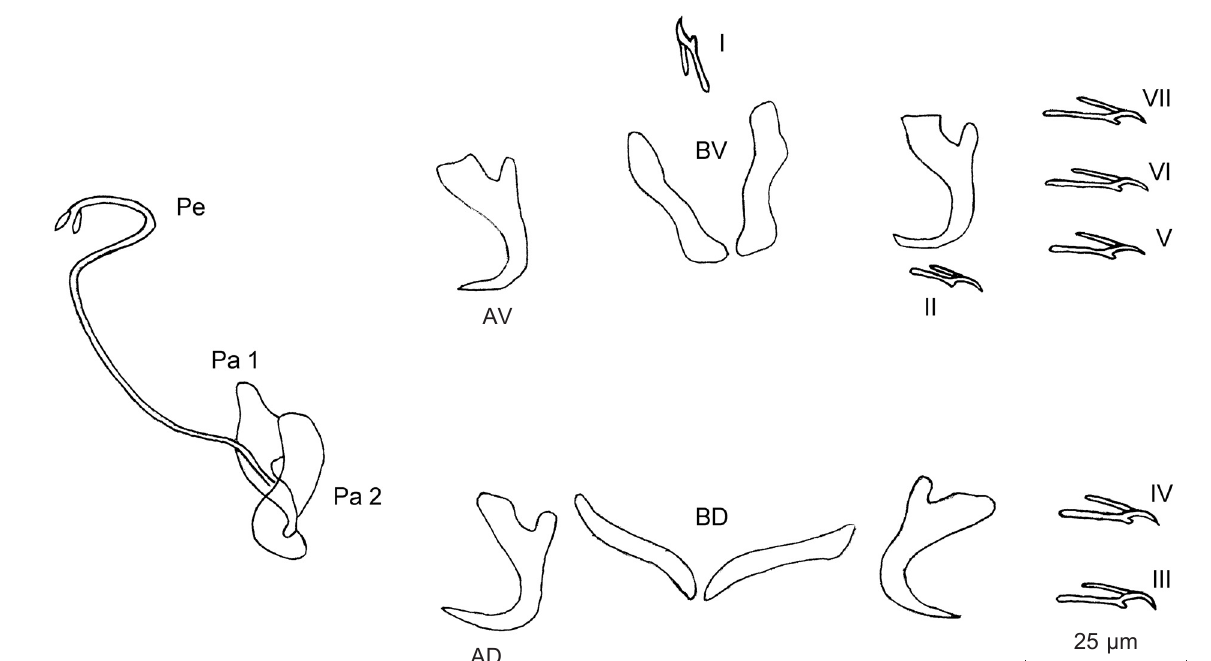
Fig. 4. – Bouixella koutouani n.